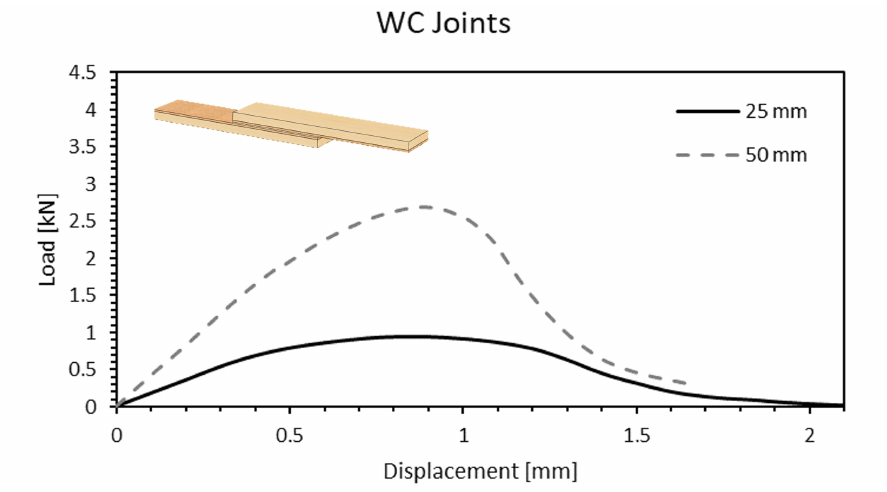
Figure 13. Load-displacement curve of a WC joint for 25- and 50-mm overlap